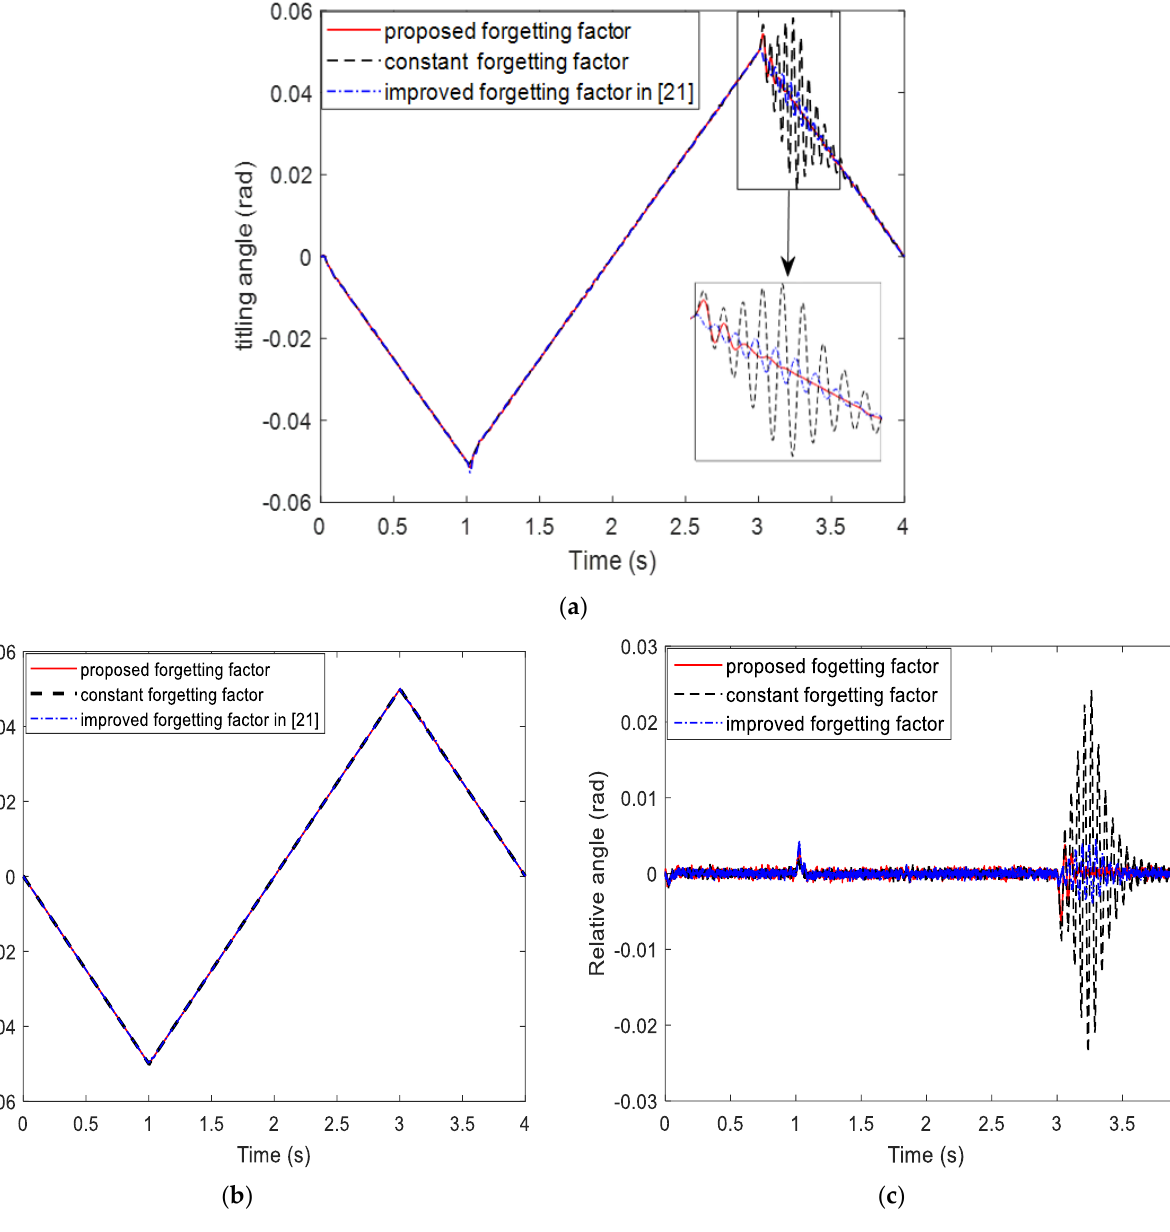
Figure 7. Titling angles of the MISP under adaptive resonance suppression: ( a ) The titling angle of the gimbal frame. ( b ) The titling angle of the stabilized platform. ( c ) The relative tilting angle of dualstage systems.